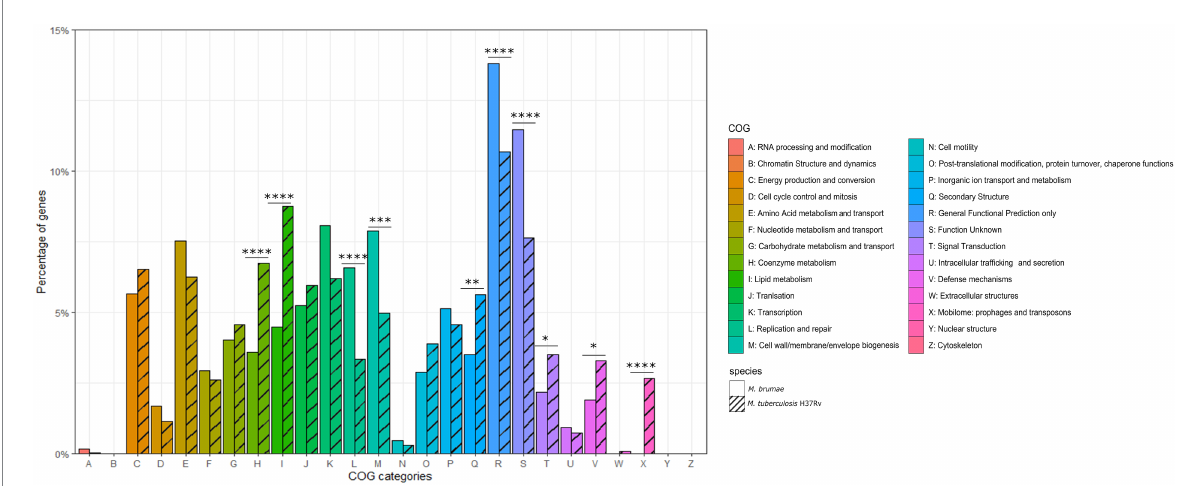
FIGURE 3 Gene annotation comparison of COG distributions shared in Mycobacterium brumae and in Mycobacterium tuberculosis H37Rv. COG refers to Clusters of Orthologous Groups. The vertical axis shows the percentage of genes in each category. The different categories are represented on the horizontal axis and the legend indicates the correspondence with each COG category. The corresponding strain for each bar is indicated in stripe pattern for M . tuberculosis H37Rv and in plain pattern for M . brumae . Fisher test p values for each category indicated as following: * p < 0.05; ** p < 0.01; *** p < 0.001; and **** p <